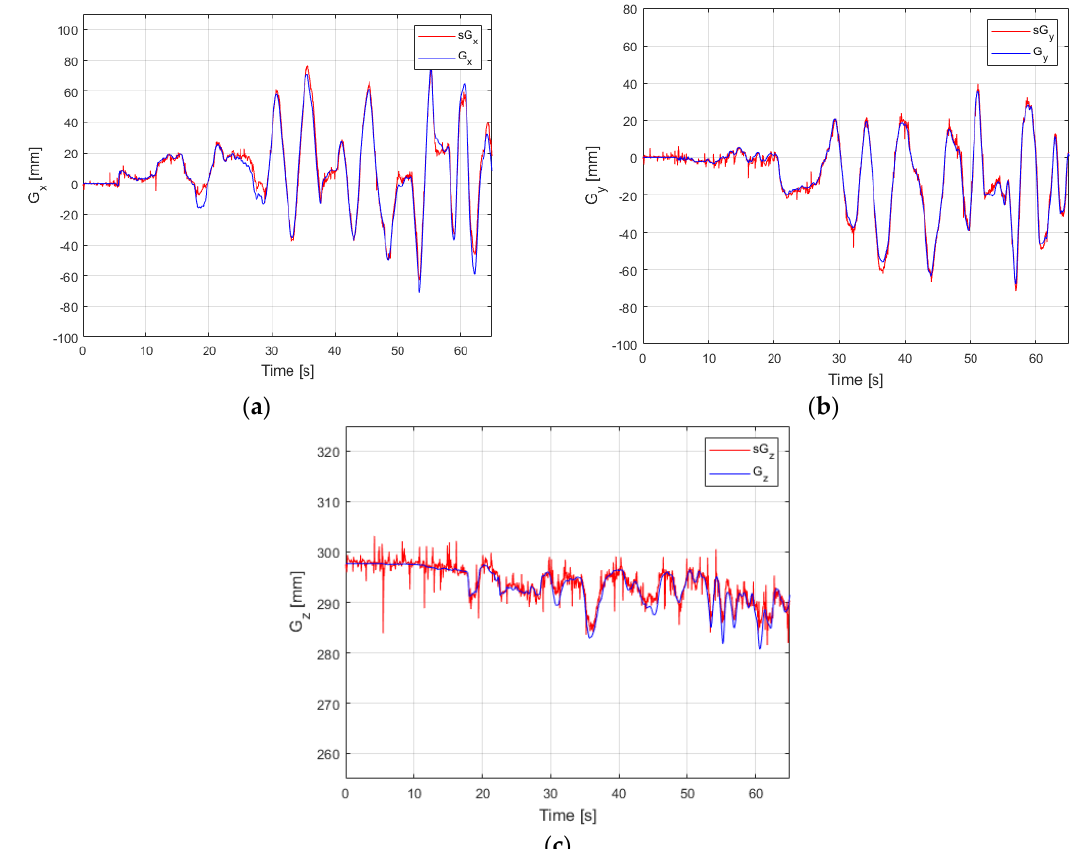
Figure 12. Experimental result—position of the end effector ( a ) parameter G x ( b ) parameter G y ( c ) parameter G z .